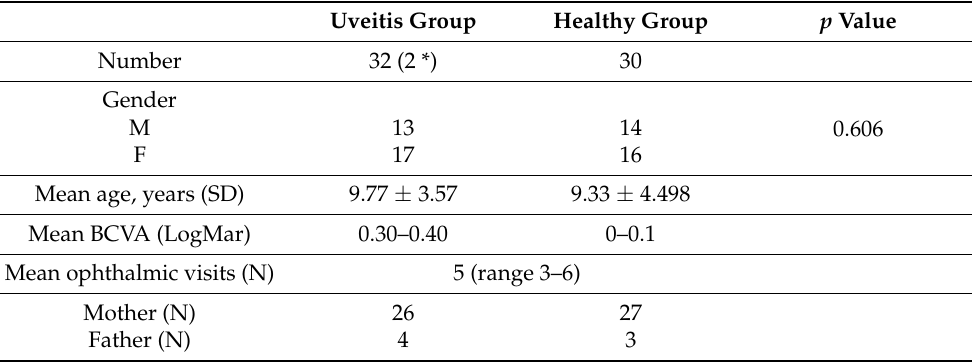
Table 1. Social demographic characteristics of patients and their parents of the two groups.